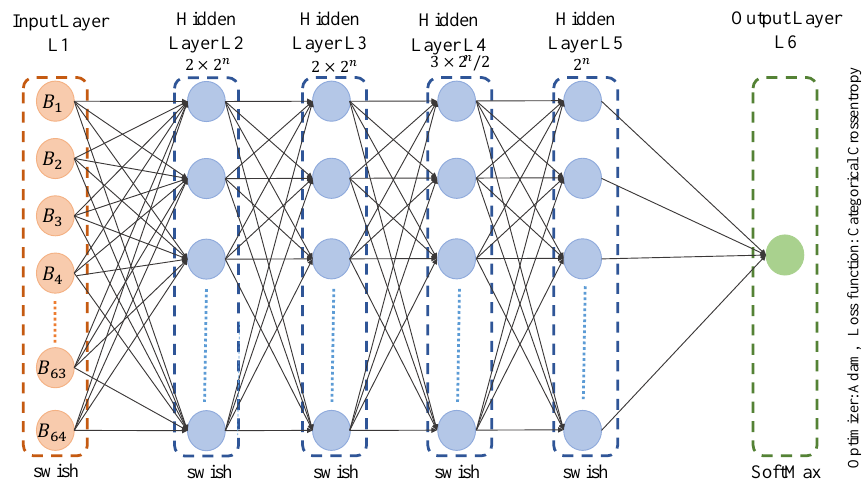
Figure 12. Multi-layer Perceptron architecture.